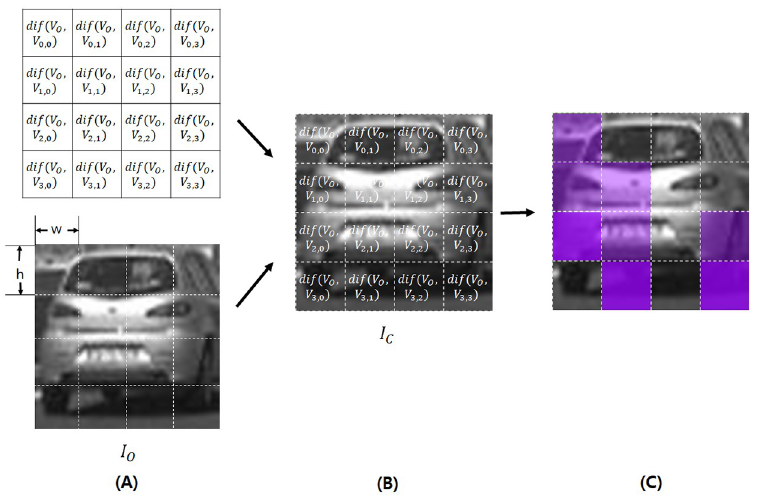
Fig 4. Describes the explanation-deriving process (step computting difference and making explanations) of our method. In (A) , we compute the difference dif( V O , V n , m ) of V O and each vector V n , m , n = 0, ... , N − 1, m = 0, ... , M − 1. In (B) , we copy I O and call it I C . In (C) , we fill the resulting image initialized as I O , with gray for each area corresponding to ( n , m )-th sub-image, and the larger the value of dif( V area. For example, in the figure above, one can see dif ( V O , V 2,0 ) is larger than dif ( V O , V 2,1 ) because, in (C) , the purple color of the cell corresponding to the former is more clear than one corresponding to the